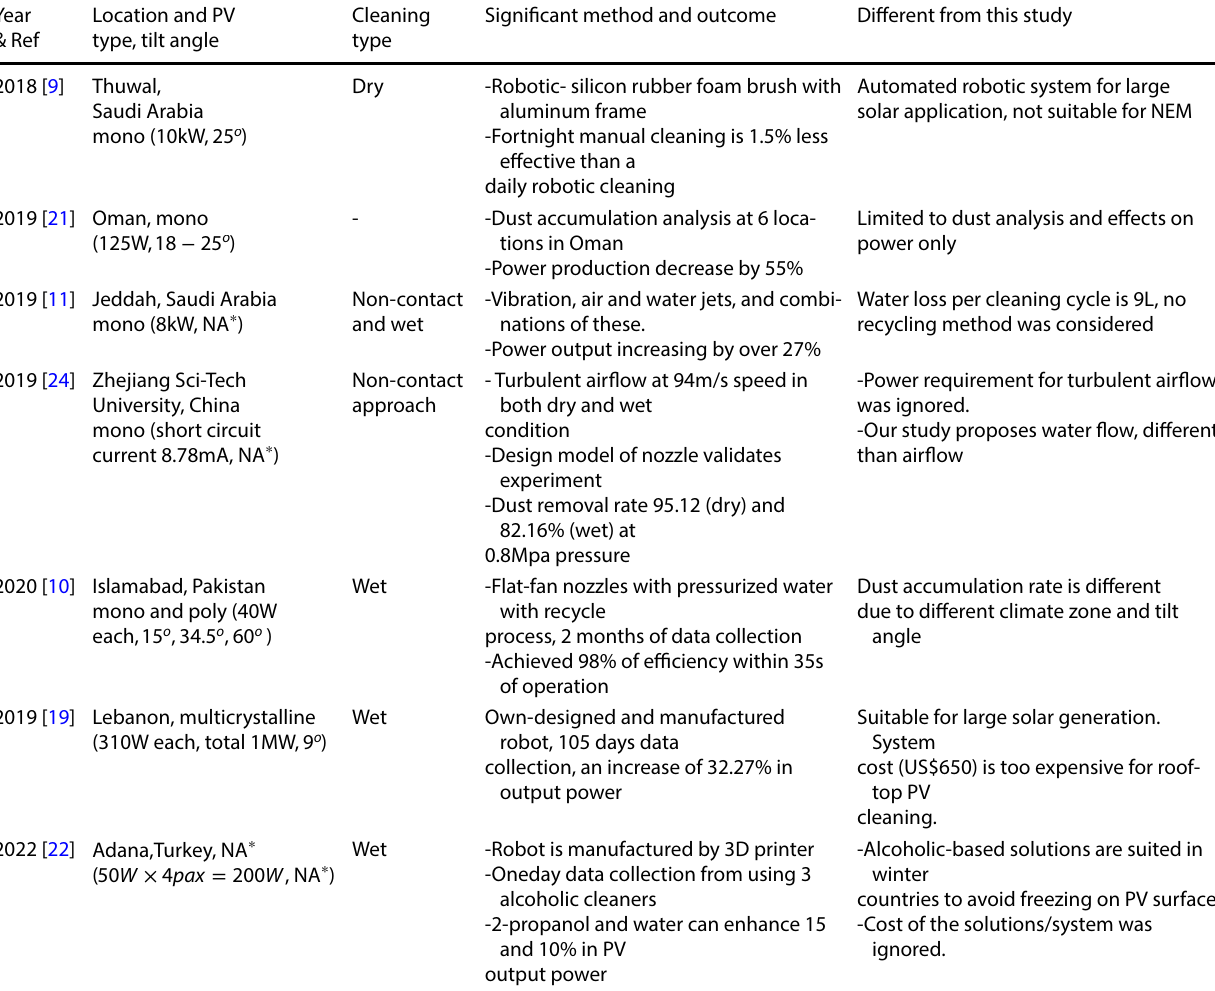
Table 1 Summary structure of related previous works based on literature